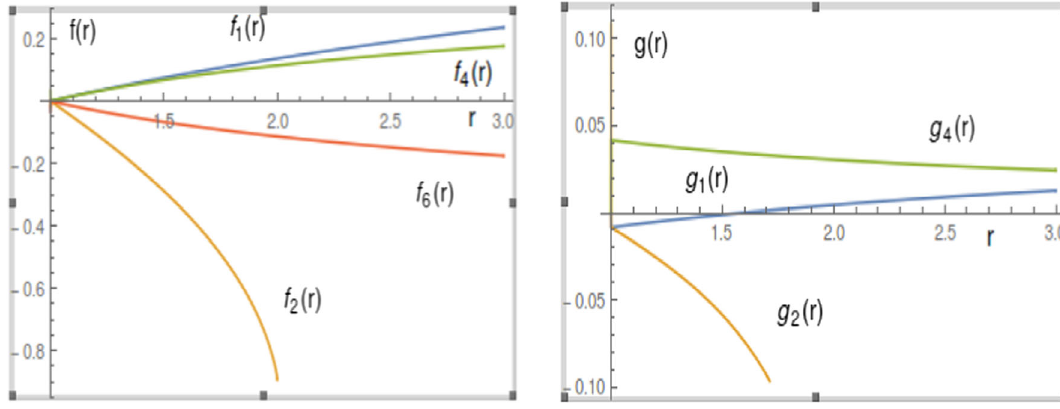
Fig. 8 Variation of f i ( r ) and g i ( r ) with